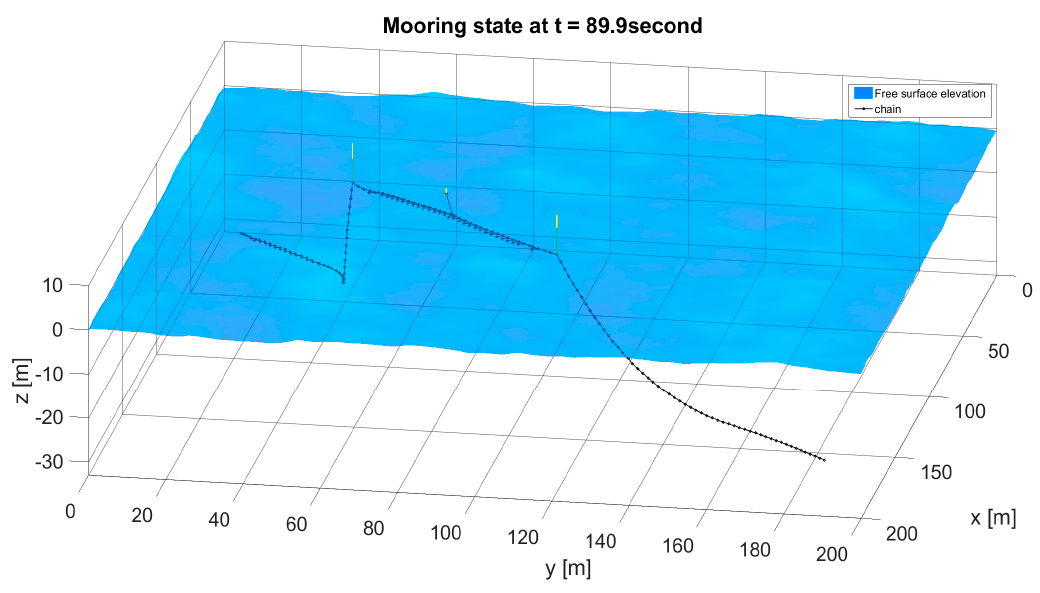
Figure 3. A numerical model of Edulis test setup line in irregular waves (mooring line state at 89.9 s). Flat bottom at z = − 30 m.